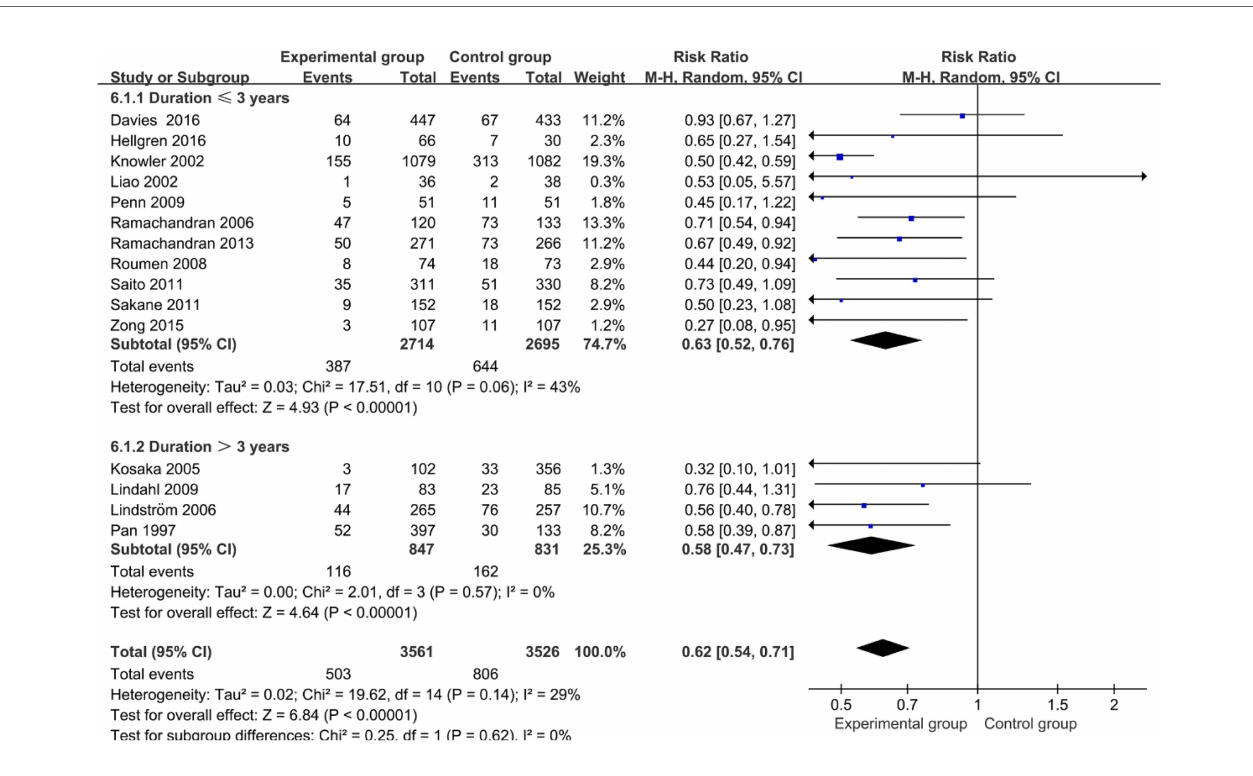
FIGURE 5 | Forest plot of subgroup analysis of diabetes incidence in intervention